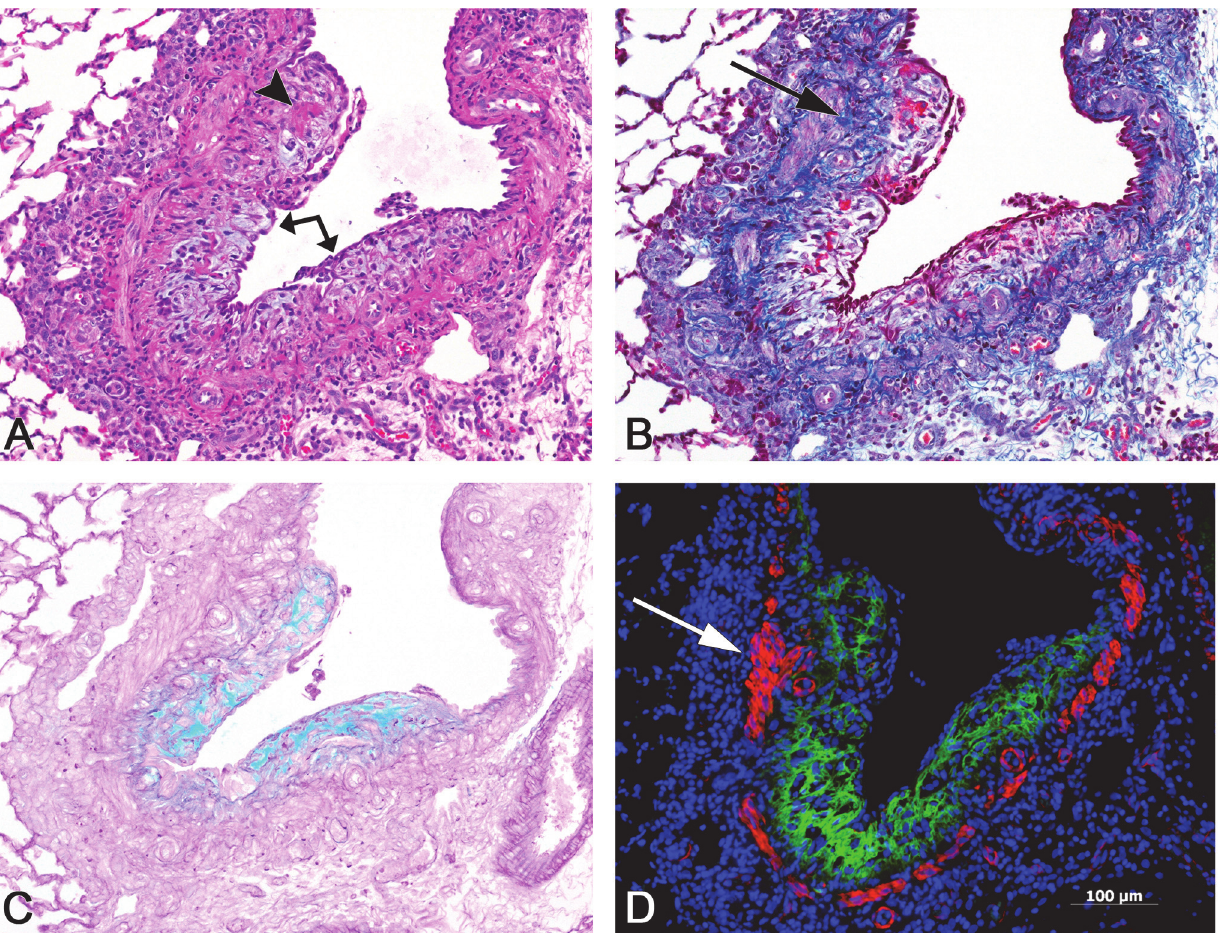
Fig 2. Bronchial fibrosis, intraluminal. Serial sections of a fibrotic bronchus. A) A plaque-like proliferation of loose, myxoid, amphophilic connective tissue (arrow) projects into and partially obstructs the lumen of this bronchial branch. The fibrotic lesion is covered by an attenuated, regenerating epithelium, and contains focal deposits of eosinophilic fibrin (arrowhead). A mononuclear cell infiltrate is present in the adventitia. H&E. B) The fibrosis is largely devoid of mature collagen, except in the deeper portions of the lesion adjacent to the smooth muscle (arrow). Masson trichrome stain. C) The loose, organizing character of the lesion is highlighted by the blue-green web-like reticular pattern demonstrated by the alcian blue stain, indicative of the presence of acidic mucopolysaccharides. D) Immunofluorescent stains were used to visualize tenascin C and smooth muscle actin. Extensive deposition of tenascin C (in green) is noted throughout much of the fibrotic lesion. The muscle layer of the bronchial wall is demonstrated in red by the smooth muscle actin antibody; focally, the muscular wall appears to be thickened (arrow). All images, 10X original objective